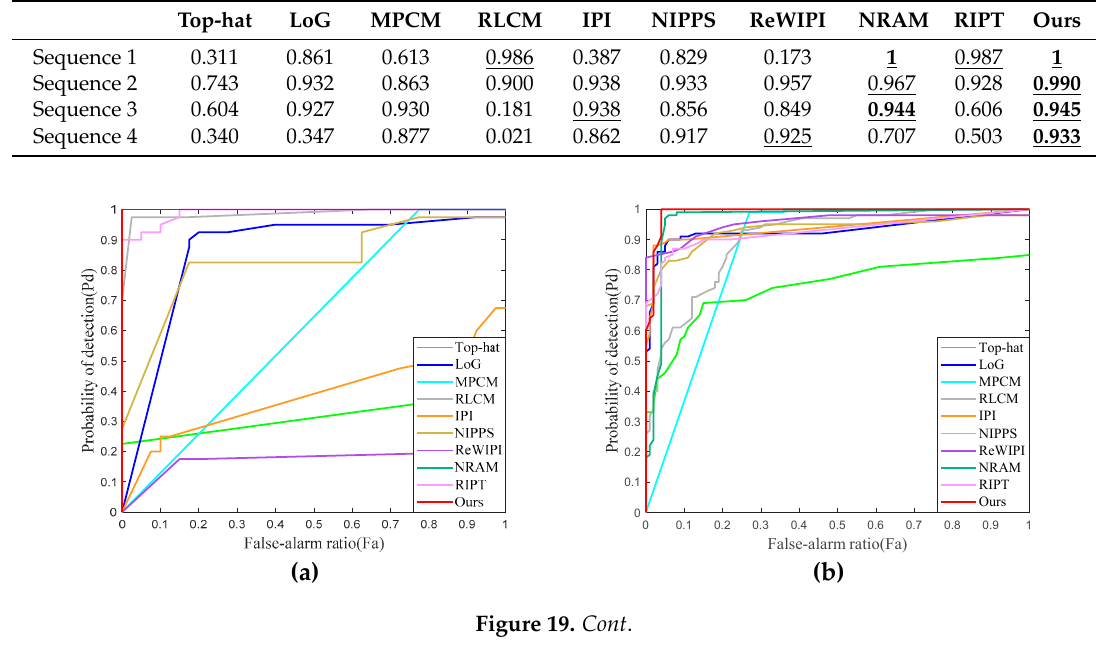
(d) Figure 19. ROC curves of detection results of four real sequences. ( a ) Sequence 1; ( b ) Sequence 2; ( c ) Sequence 3; ( d ) Sequence 4. Table 6. Area under curve (AUC) values of the 10 methods. Top-hat